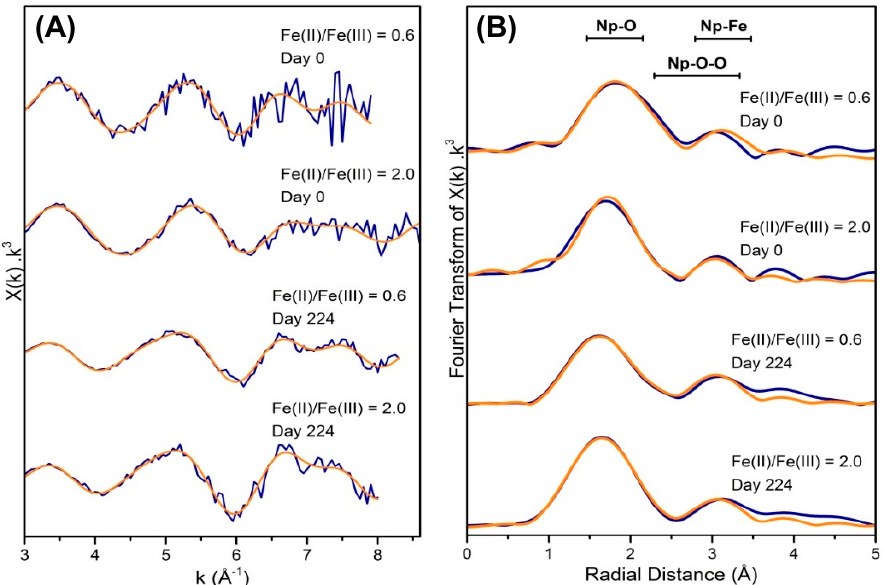
Figure 3. ( A ) Neptunium L 3 - edge EXAFS spectra and ( B ) corresponding Fourier transforms of the EXAFS data for both Fe(II)/Fe(III) = 0.6 (magnetite) and Fe(II)/Fe(III) = 2.0 (green rust) samples for freshly co-precipitated samples and for 224 day oxidised samples at approximately 300 ppm neptunium. Blue lines are k 3 -weighted data and orange lines are best fits to the data.